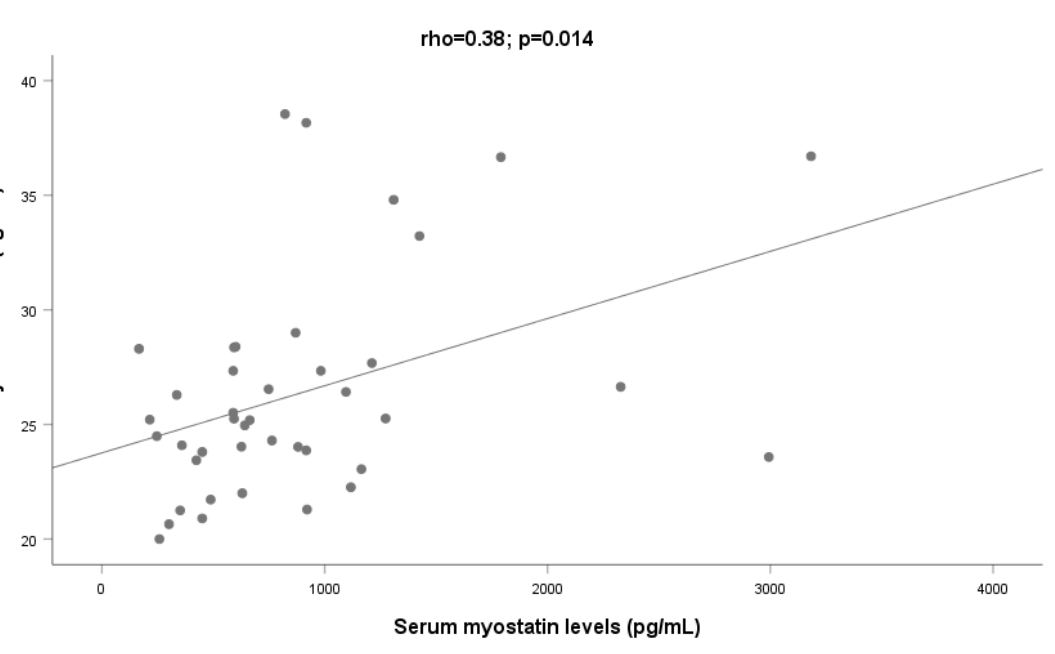
Figure 3. Relationship between serum myostatin and total lean mass among patients (N = 46). There was no relationship between myostatin and handgrip (ρ = 0.13; p = 0.42), but there was a strong inverse correlation between age and handgrip (ρ = −0.51; p < 0.001) and a direct one between handgrip and BMI (ρ = 0.30; p = 0.04). A significant relationship was observed between myostatin and BMI (ρ = 0.38, p = 0.014; Figure 4) that was even stronger when only patients without ascites (n = 38) were considered (ρ = 0.42; p = 0.010).